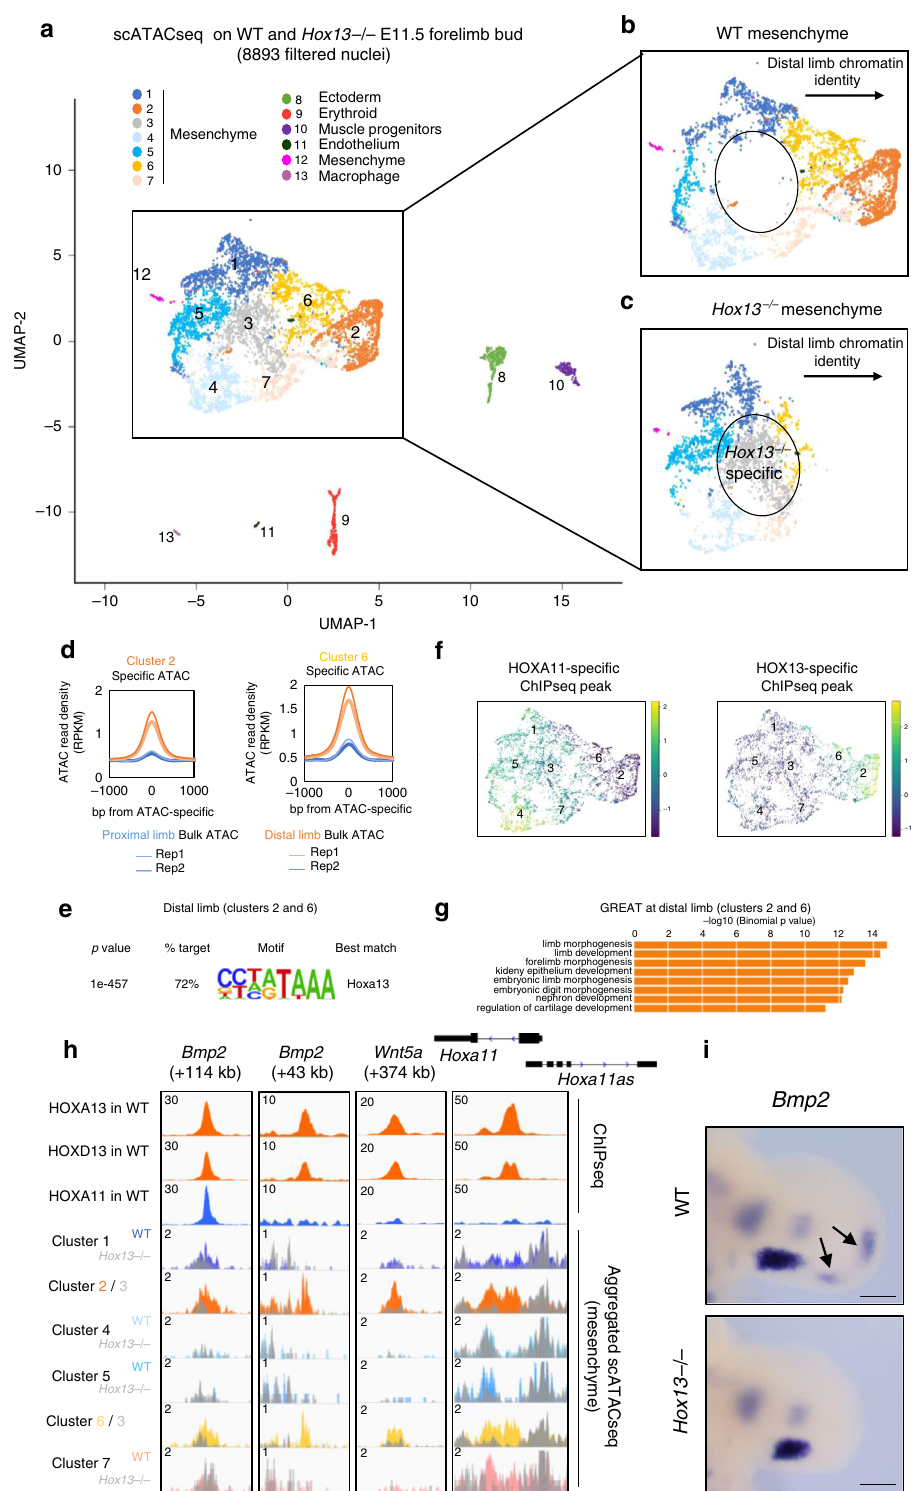
aggregated accessibility pro fi les of several marker genes (Sup- plementary Fig. 7). Consistent with Hox13 being expressed in the limb mesenchyme, we observed changes in the clustering of Hox13 − / − cells only within the mesenchymal cell population (Fig. 3b, c, Supplementary Fig. 8a, b). Among the wild-type mesenchymal cell clusters, clusters 2 and 6 were the only clusters with an average pro fi le speci fi c for the distal limb, as identi fi ed